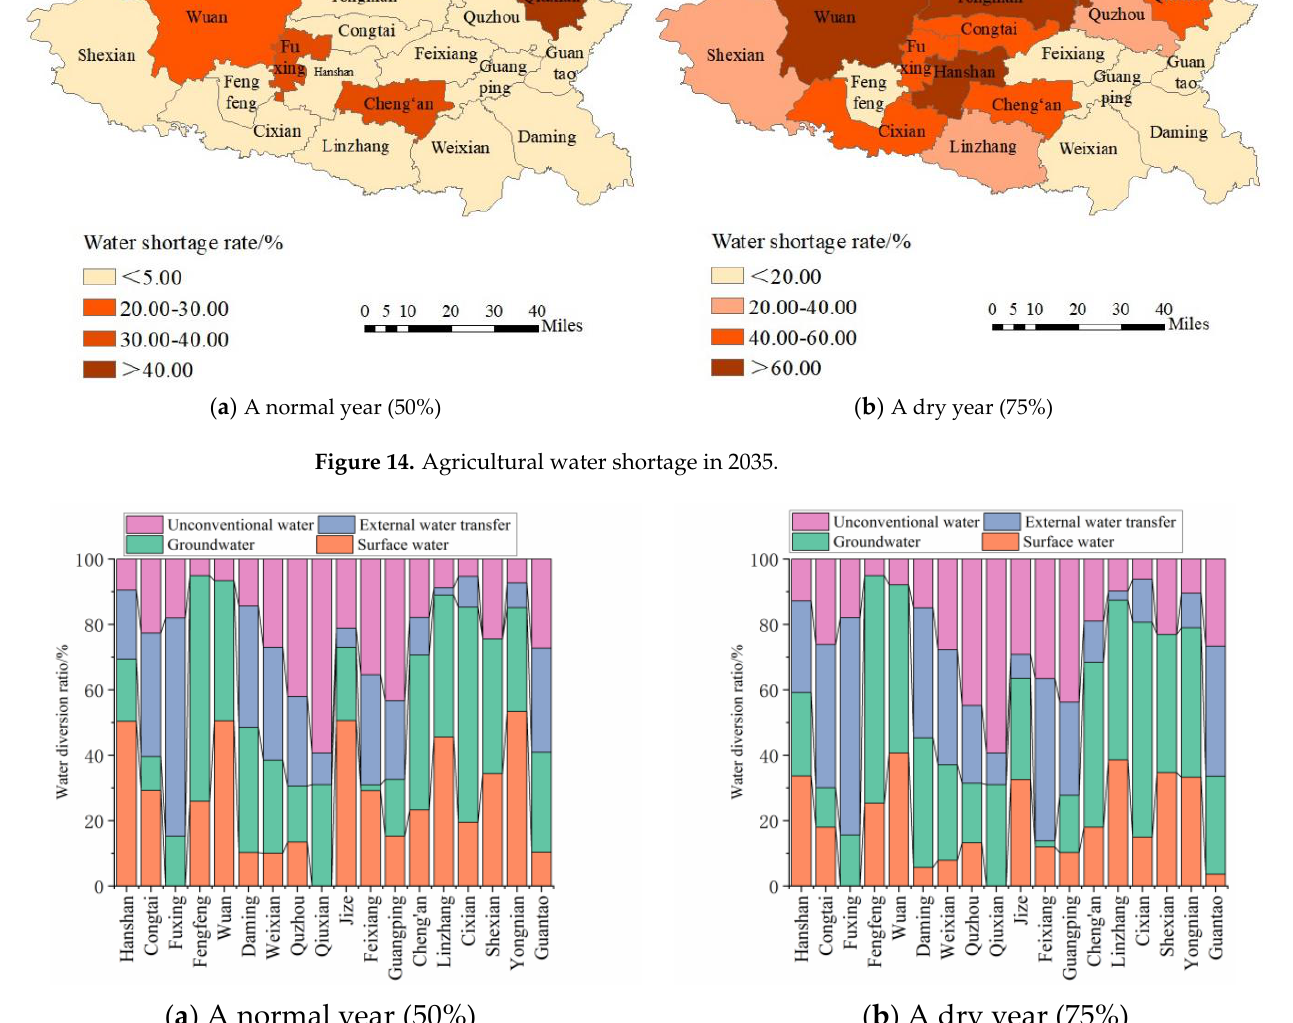
Figure 15. The structure of water supply source in 2025.